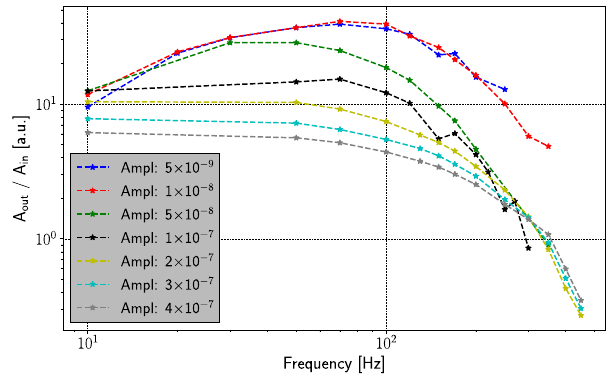
FIG. 2. Simulated fixed amplitude transfer functions for the full extraction process. The injected amplitudes are reported in the legend and are expressed in units of m − 2 , i.e., normalized quadrupole strength. For reference, the nominal quadrupole strength is of the order of 1 . 5 × 10 − 2 m − 2